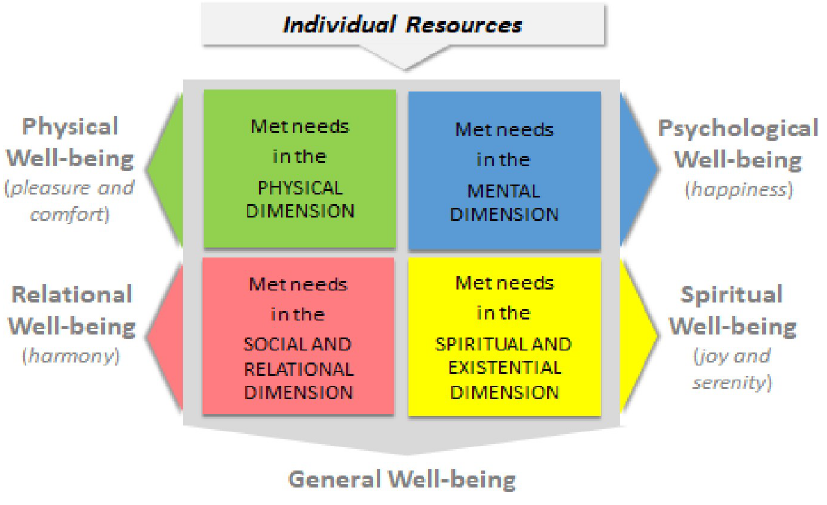
Fig 1. Multidimensional model of